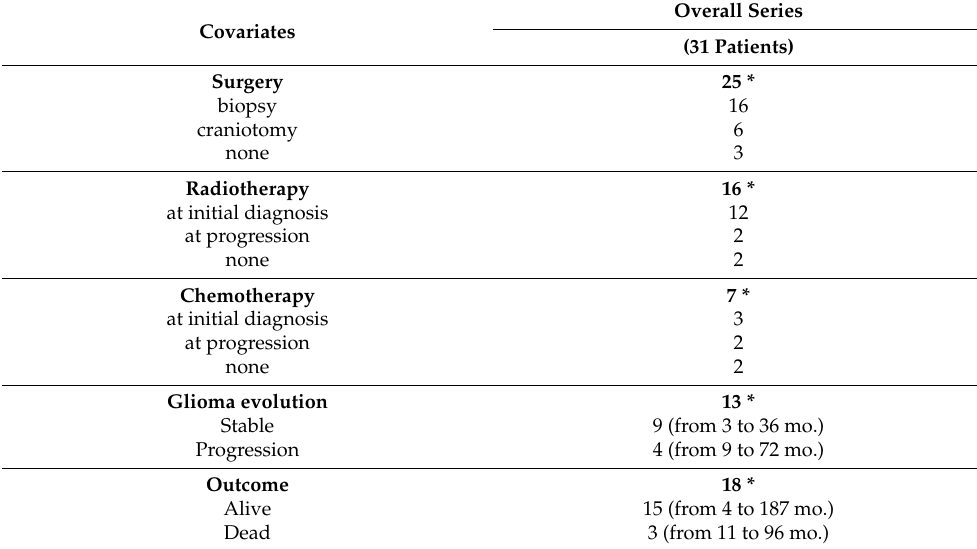
Table 3. Summary of the data on management and outcome of the 31 reported cases of OD with brain